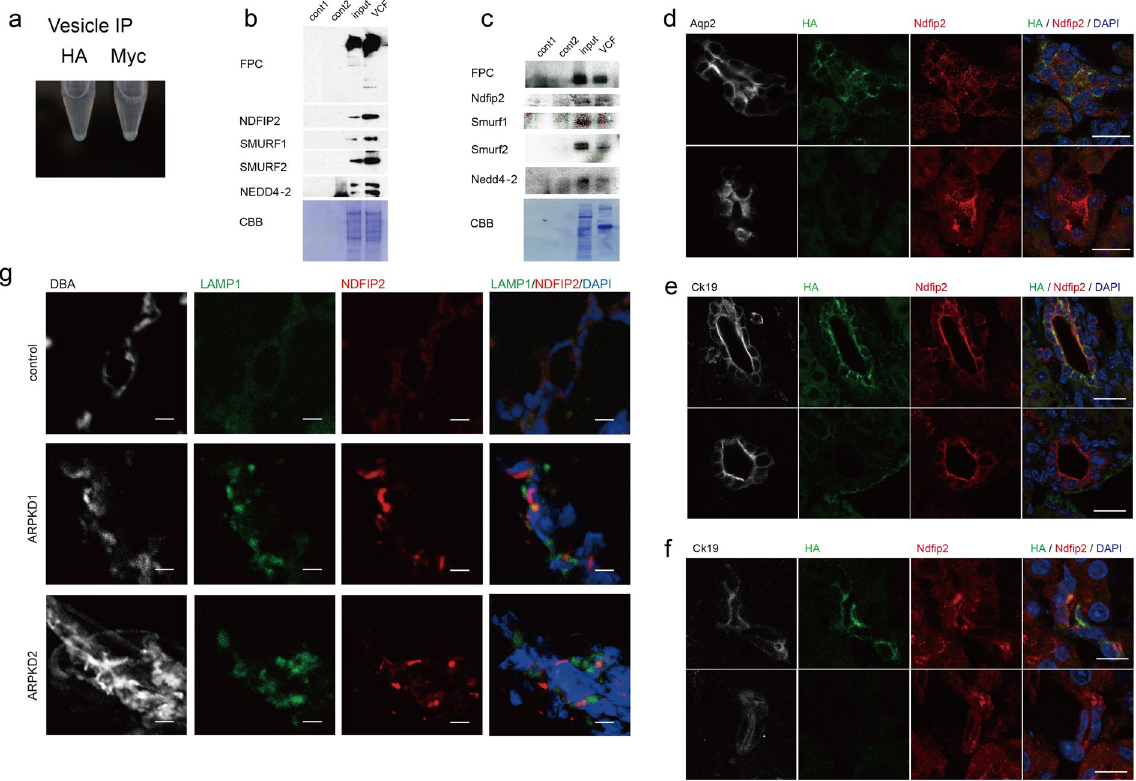
Figure 5. FPC positive vesicles contain NEDD4 interacting protein NDFIP2. ( a ) Microtube containing pellet of vesicles isolated from HEK cells expressing PKHD1-Myc using either anti-HA or anti-Myc coupled beads. A small pellet is visible in the anti-Myc sample but not in the anti-HA negative control. ( b ) Immunblot of vesicles isolated using either anti-Myc (lanes 1,4) or anti-FLAG (lane 2) coupled beads from HEK cells with either vector control (lanes 1,2) or expressing PKHD1-Myc (lane 4) and analyzed with antibodies against Myc, NDFIP2, SMURF1, SMURF2 and NEDD4-2. Lane 3 contains 20 μ g of total lysate of the PKHD1-Myc sample. Total protein quantity was accessed by Coomassie brilliant blue staining (CBB). ( c ) Immunblot of vesicles isolated using either anti-HA (lanes 1, 4) or anti-FLAG (lane 2) coupled beads from fresh kidneys of wild type (lanes 1, 2) or Pkhd1 HA-Flox mice (lane 4) and probed with antibodies against HA, Ndfip2, Smurf1, Smurf2 and Nedd4-2. Lane 3 contains 20 μ g of total lysate of the Pkhd1 HA-Flox sample. Total protein quantity was assessed by Coomassie brilliant blue staining (CBB). Anti-HA detects full length Fpc. The full-length blots of cropped images in b and c are included in Supplementary Fig. S9. ( d–f ) Confocal analysis of kidney ( d ), liver ( e ), and pancreas ( f ) from Pkhd1 HA-Flox (top panels in each) or wild type mice (bottom panels in each) for Fpc (HA) (green), Ndfip2 (red), DAPI (blue) and markers for collecting duct (aquaporin 2, Aqp2) or epithelial cells (cytokeratin 19, Ck19). Merged images are on far right. Scale bars, 20 μ m in “d” and “e” and 10 μ m in “f”. ( g ) Kidney specimens from human control (control) and two different ARPKD donors (ARPKD1, ARPKD2) stained for DBA (grey), LAMP1 (green), NDFIP2 (red) and DAPI (blue). Scale bars, 10 μ